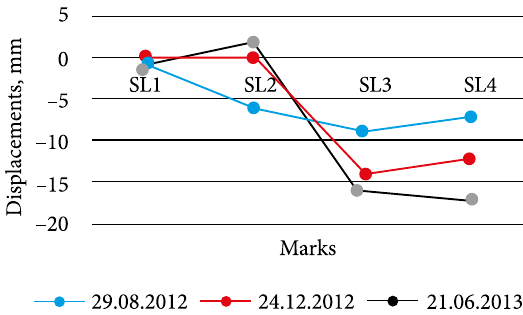
Fig. 4. The displacements of the reflectors in the direction of the cross axis for the north-east facade.